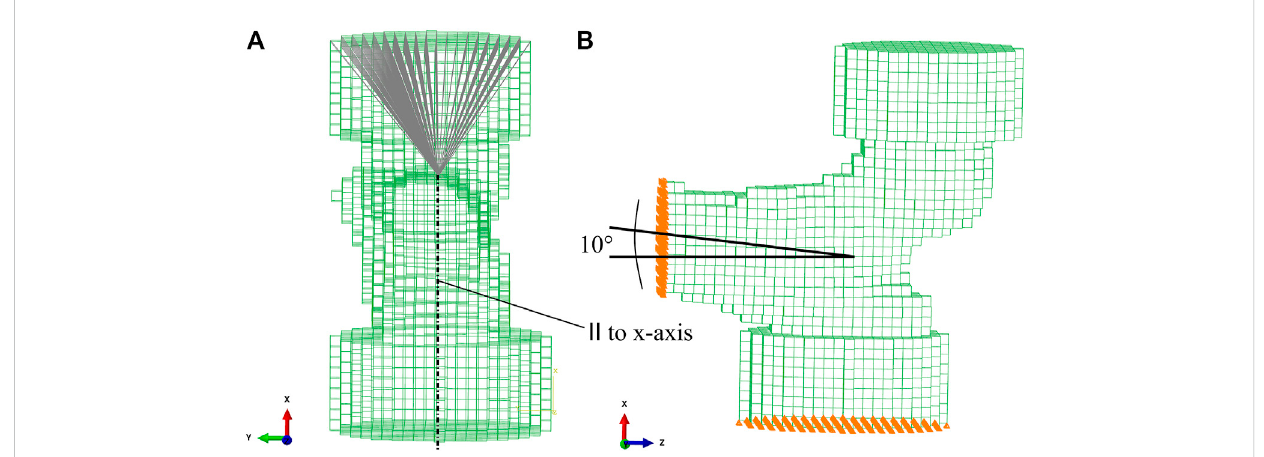
FIGURE 4 FE mesh with embedding caps. (A) Kinematic coupling between the driving node at the center of the femoral head and the upper surface of the embeddingcap. (B) 10 ° inclinationoftheproximalshaftaxis.Nodesonthedistalcutsurfacewerefullyconstrained.NodesonthelowersurfaceoftheGT embedding were constrained in the vertical direction and free to move